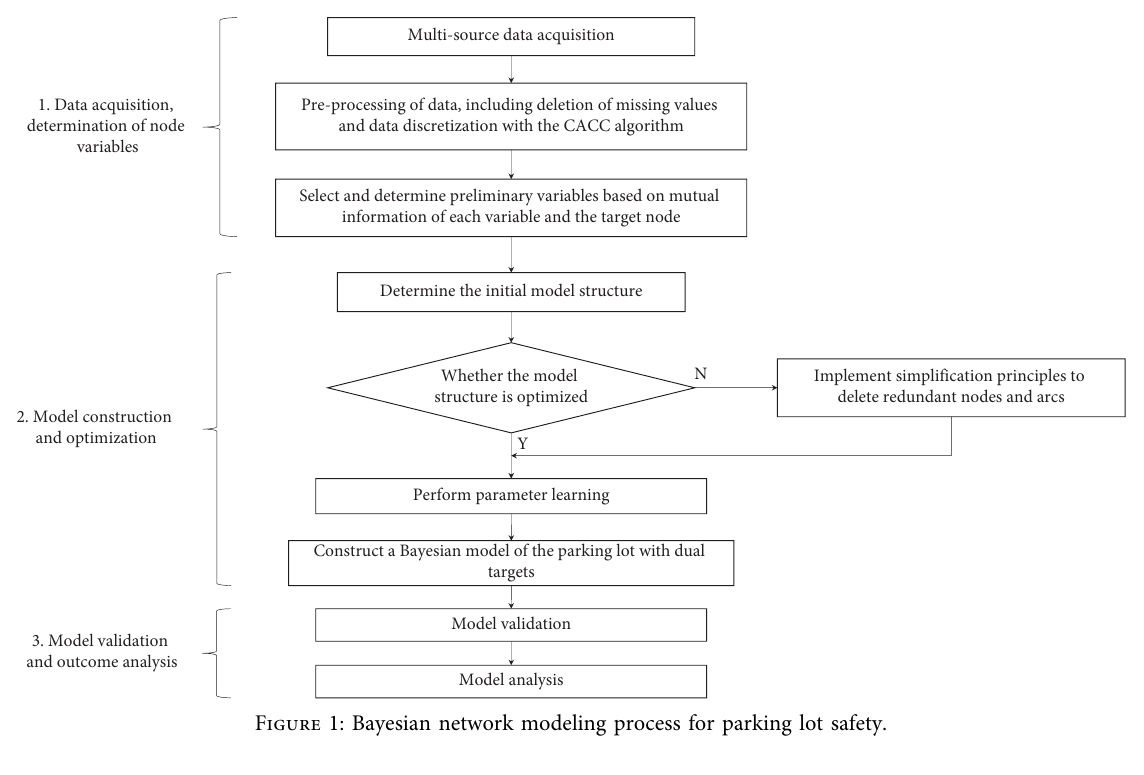
Figure 1: Bayesian network modeling process for parking lot